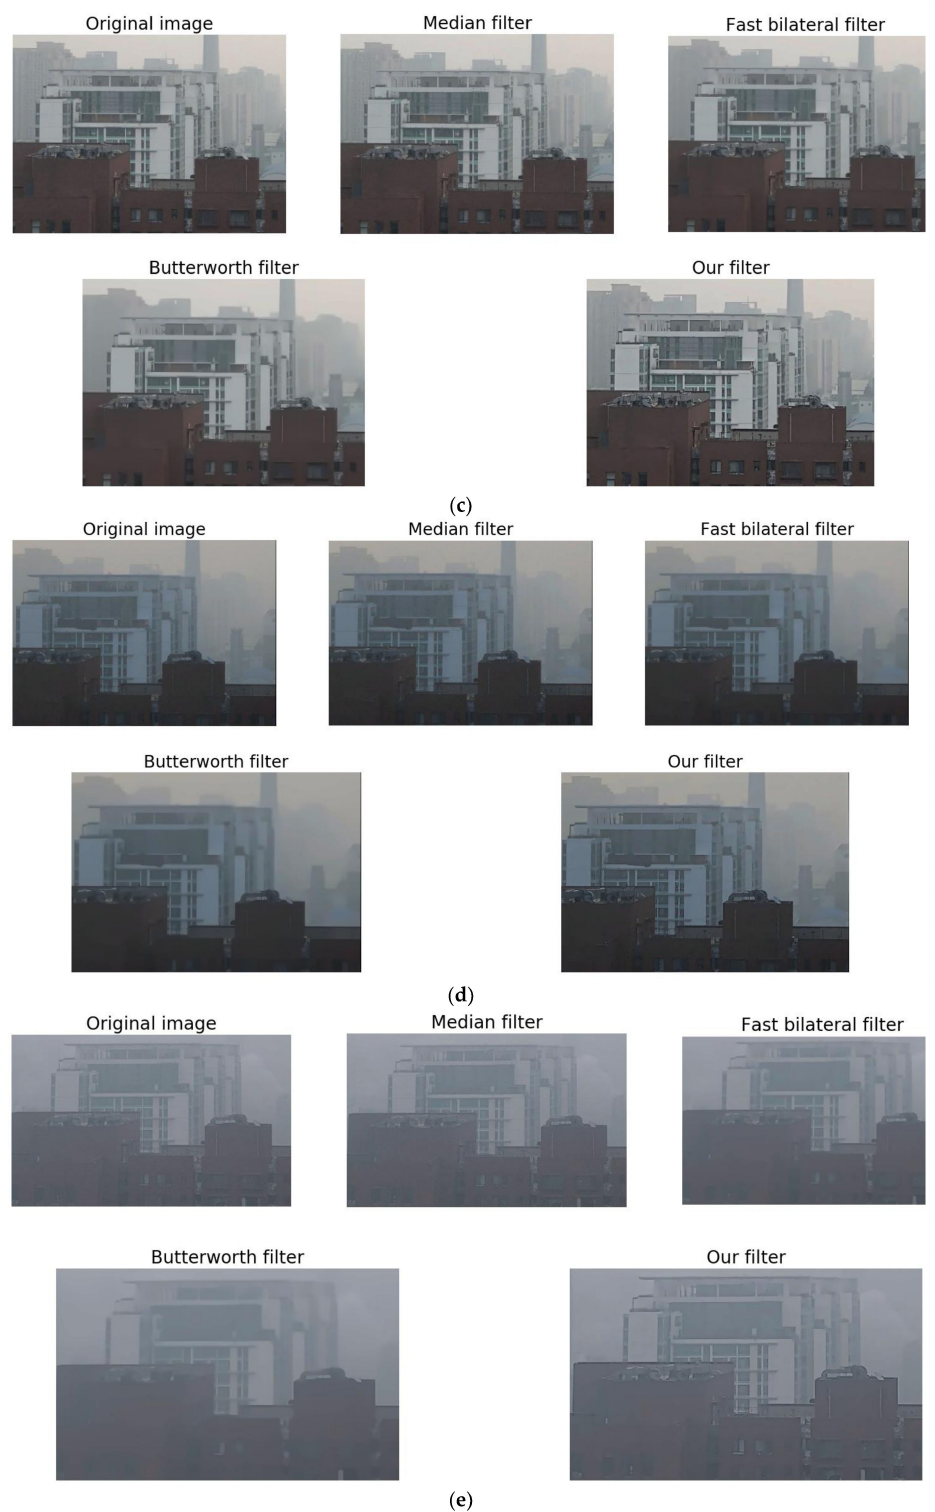
Figure 21. Comparison of different filters. ( a ) is the filters comparison when level is excellent; ( b ) is the filters comparison when level is good; ( c ) is the filters comparison when level is light; ( d ) is the filters comparison when level is moderate; ( e ) is the filters comparison when level is